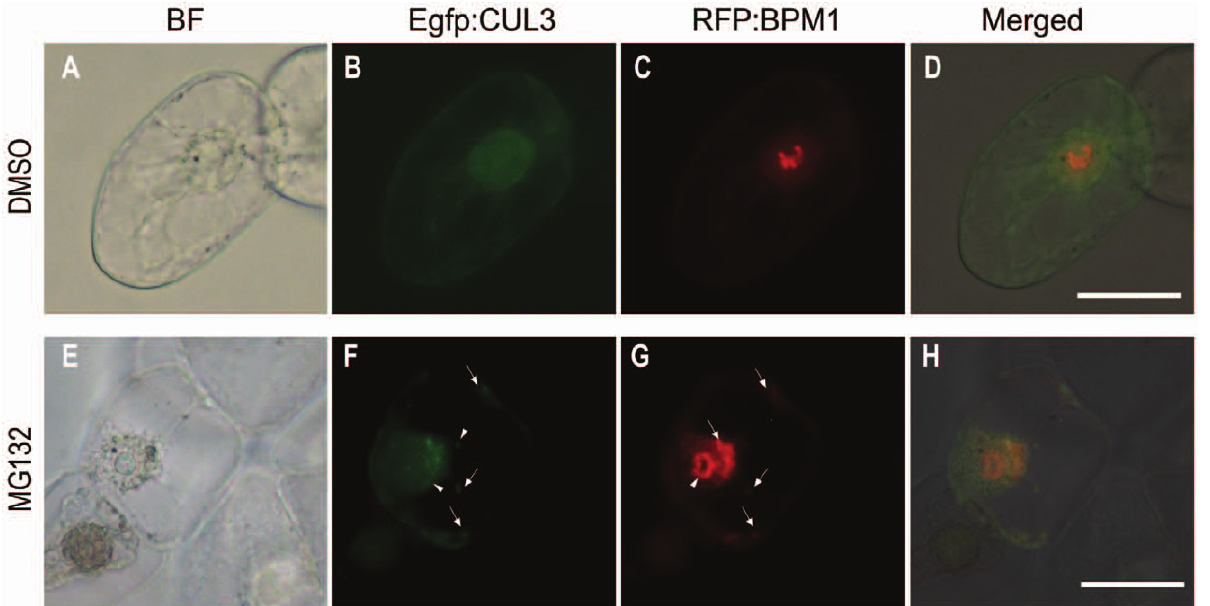
Figure 5. Subcellular localization of CUL3 and BPM1 proteins in the tobacco BY2 cells. CUL3 and BPM1 overlap in the cytoplasm but not in the nucleolus (A–D). After proteasome inhibition with 50 m M MG132, CUL3 and BPM1 accumulate in the cytoplasm which implies their cytoplasmic proteosomal degradation (E–H). Images shown are bright field (BF), Egfp and RFP fluorescence from CUL3 and BPM1 respectively, and a merged image. Arrowheads indicate cytoplasmic agglomerates where both proteins co-localize. Arrows indicate agglomerates of a particular protein. Bars